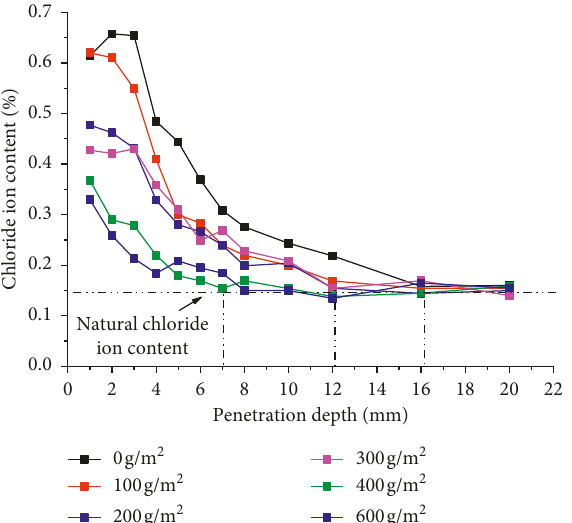
Figure 12: Chloride profiles measured in C-SSR after 28 days of immersion in 0.5% NaCl.